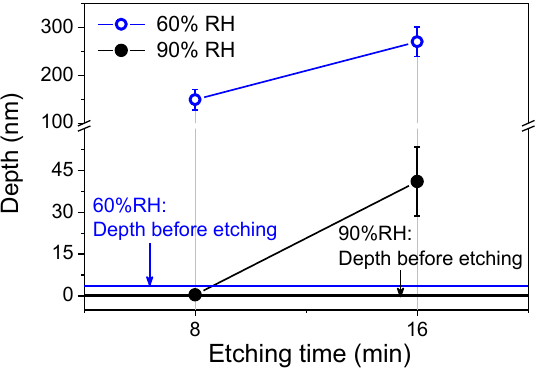
Figure 4. The depth of wear scars on silicon surface after different etching time between 60% RH and 90% RH. F n = 3 μN, N = 2, A = 1 μm × 1 μm, v = 4 μm/s, ω KOH = 10%.